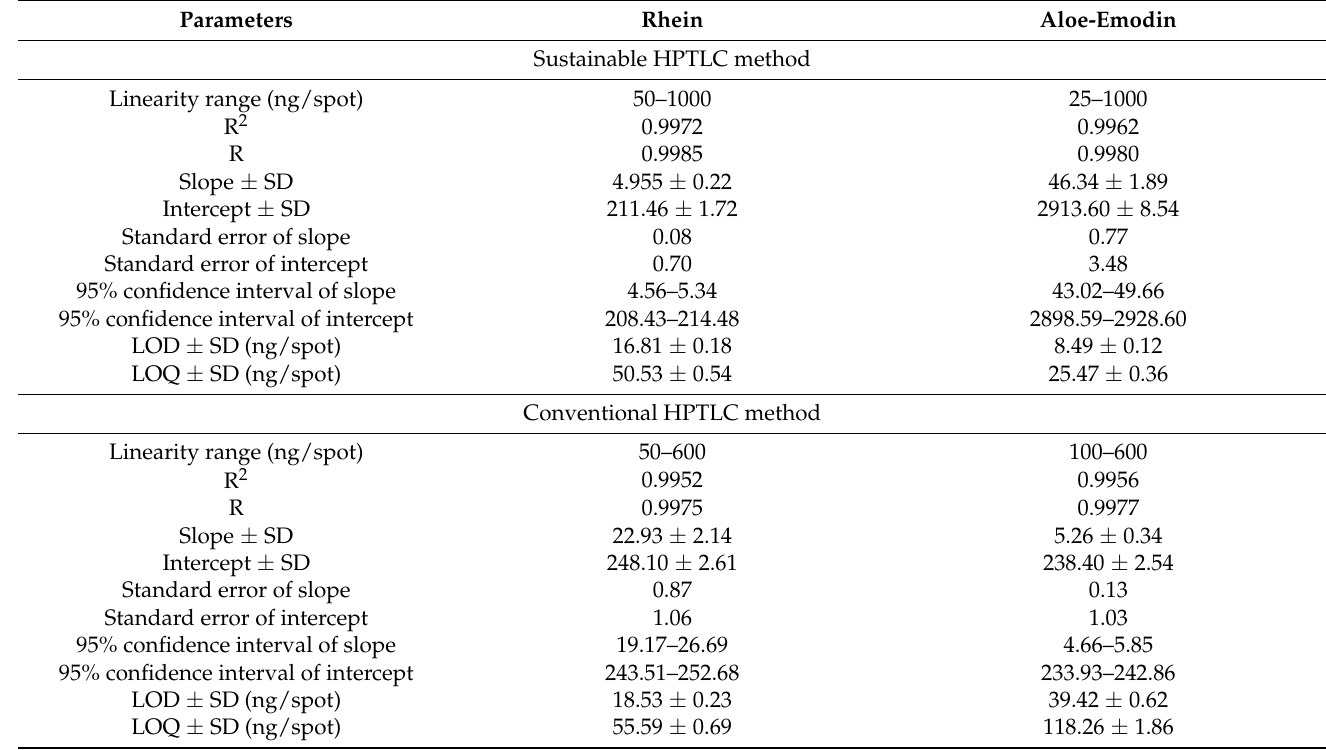
Table 1. Outcomes of linearity evaluation for the simultaneous quantification of rhein and aloe- emodin utilizing the sustainable and conventional analytical assays (mean ± SD; n = 6).